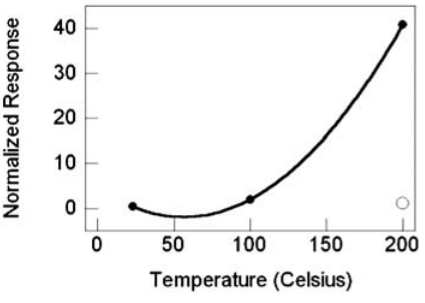
Figure 23. TiO nanowire sensor response versus temperature, filled circles are with Pt 2 catalyst, the nonfilled circle is without